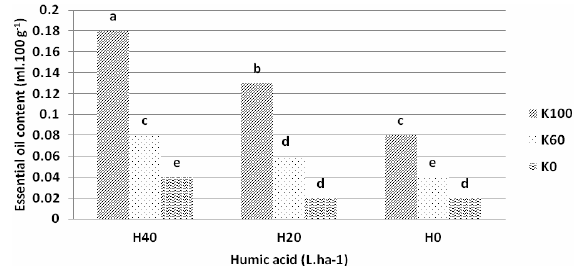
Fig. 5. Effect of humic acid and potassium sulphate on essential oils